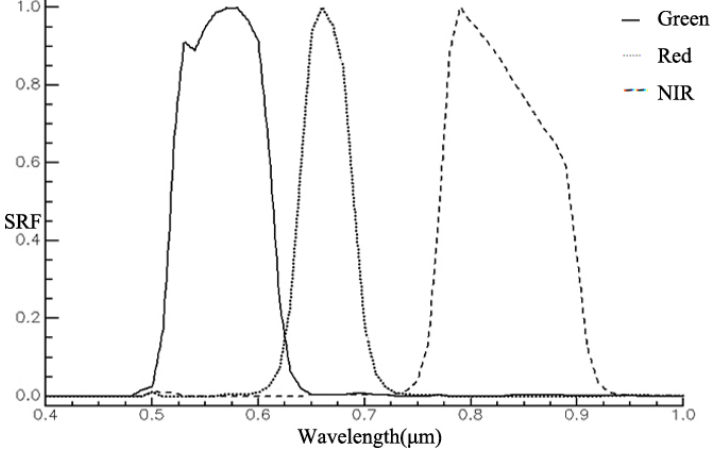
Figure 3. Spectral response function of